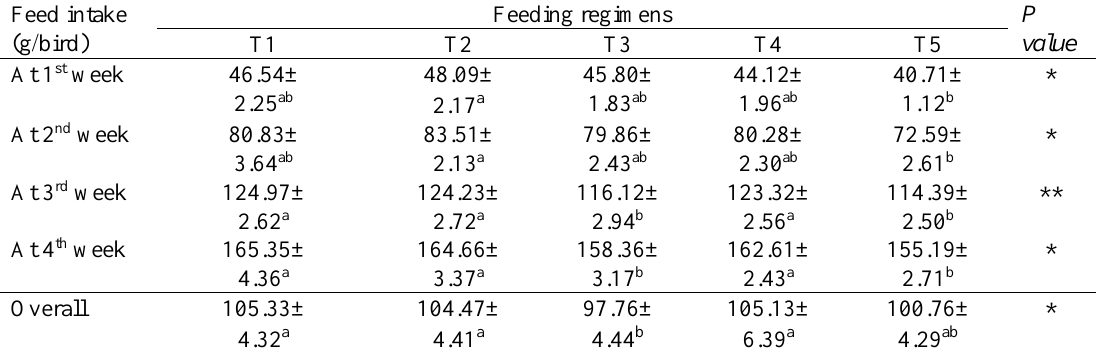
Feeding regimens